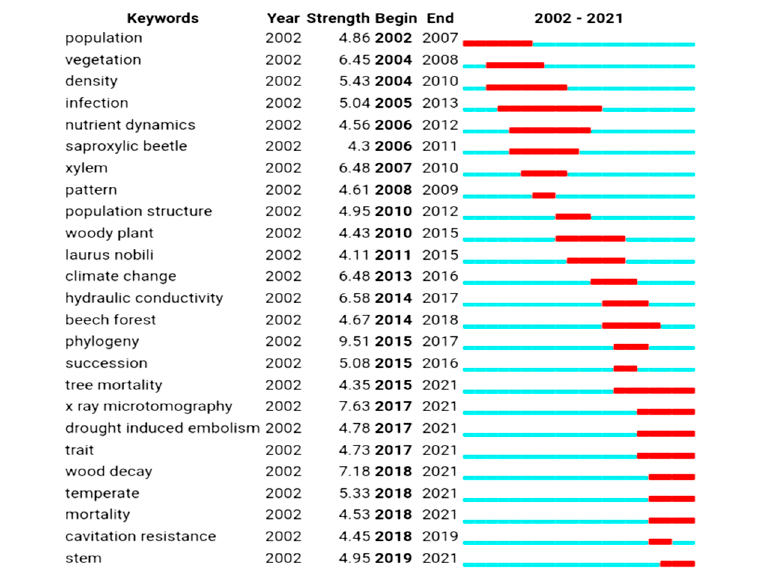
Figure 4. List of keywords with high bursts strength from 2002 to 2021.